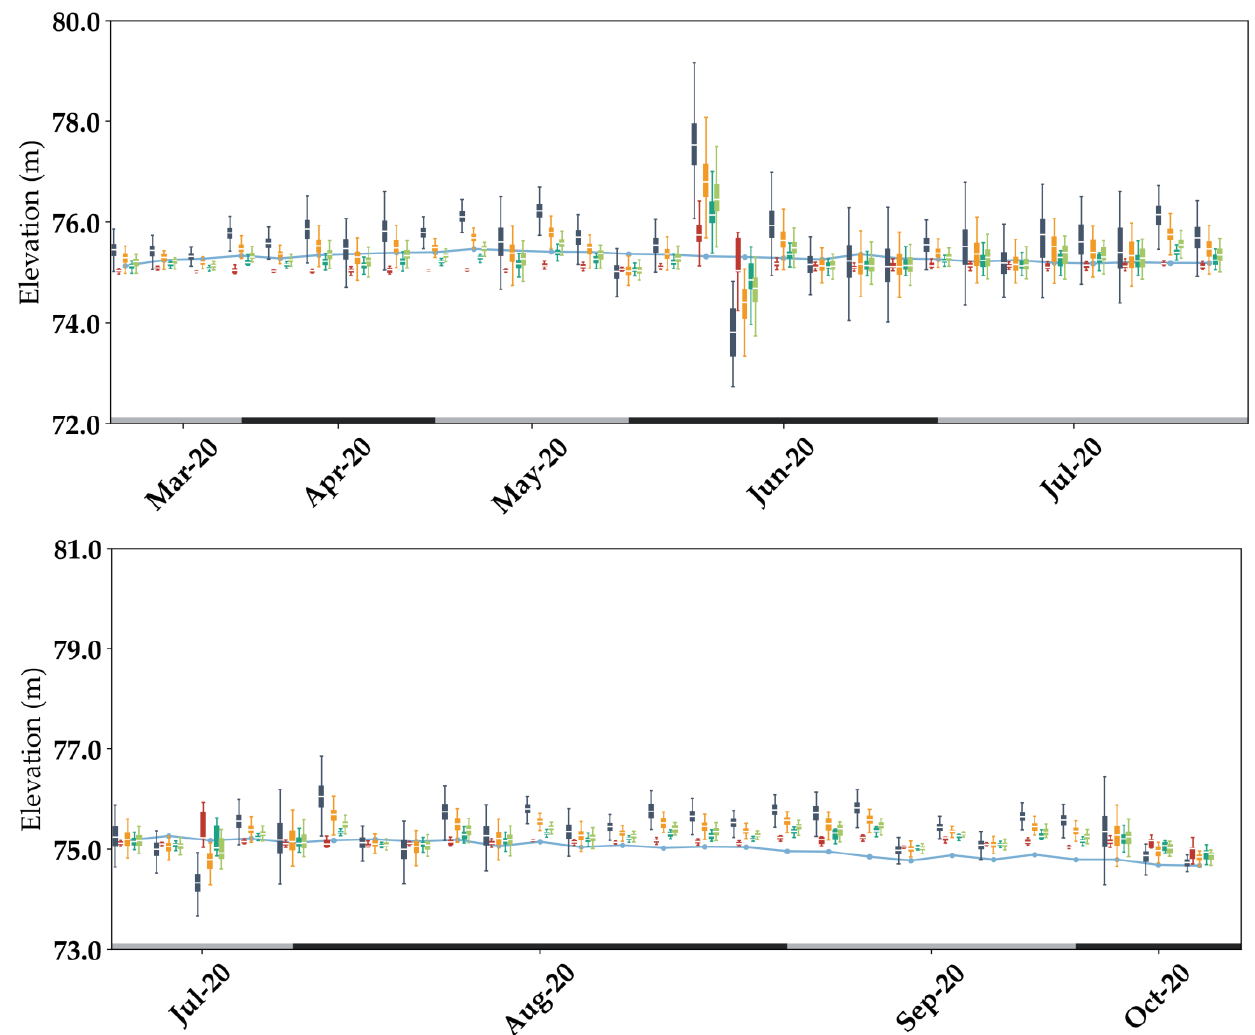
Figure A3. Boxplot by track of the original estimated elevations by GEDI over Lake Ontario and the four tested models presented in Sections 3.1.1 and 3.1.2. The blue line represents in situ elevations.